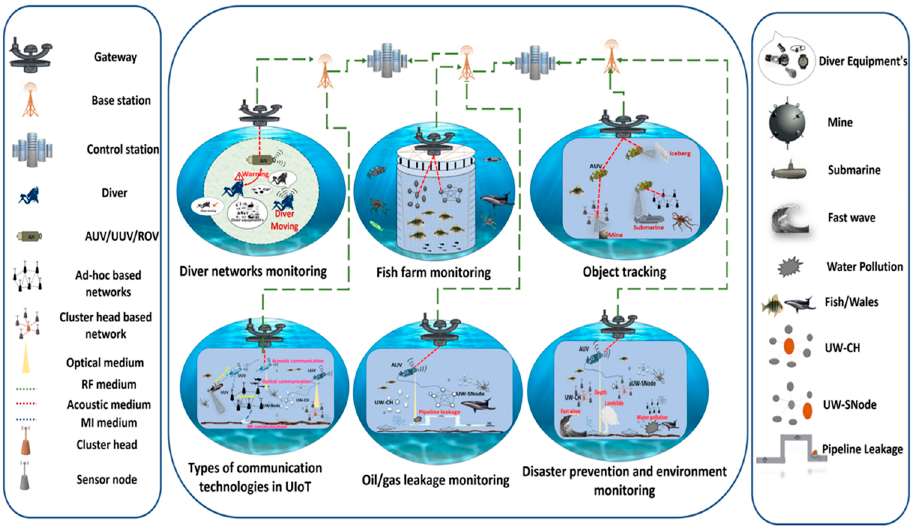
Figure 1. UIoT core applications, devices, and communication technologies.